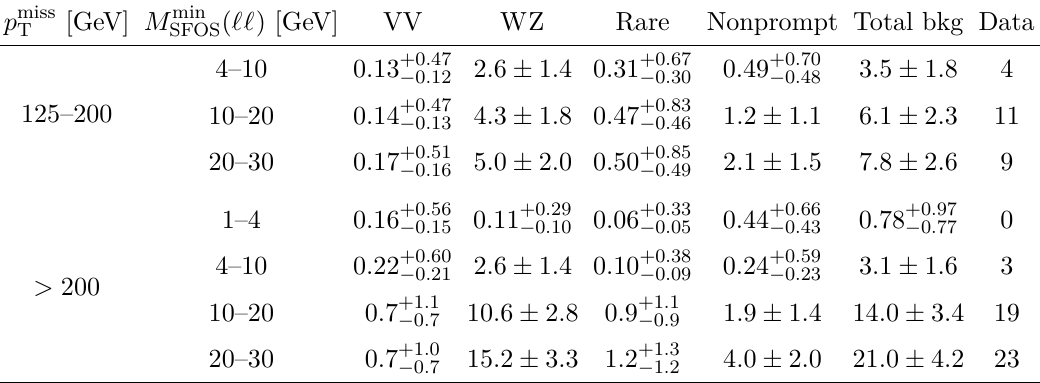
Table 6 . Observed and predicted yields as extracted from the maximum likelihood fit, in the WZ -like selection SRs. Uncertainties include both the statistical and systematic